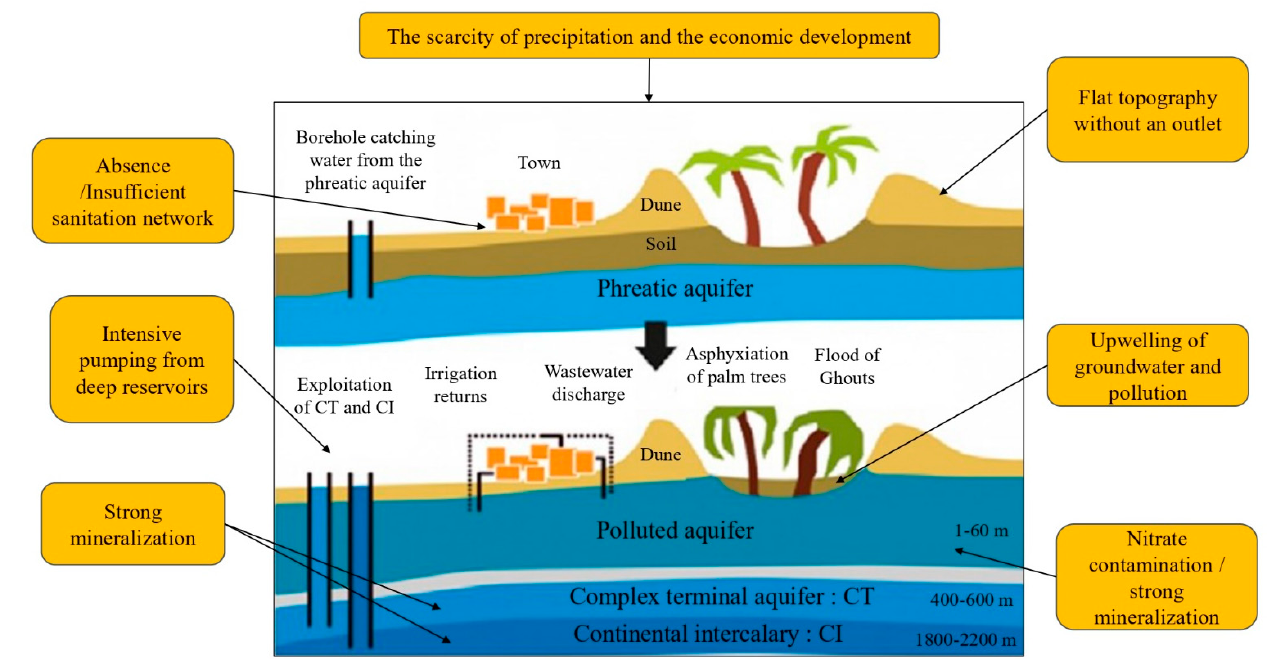
Figure 4. The generating factors of groundwater rising modified from [27].